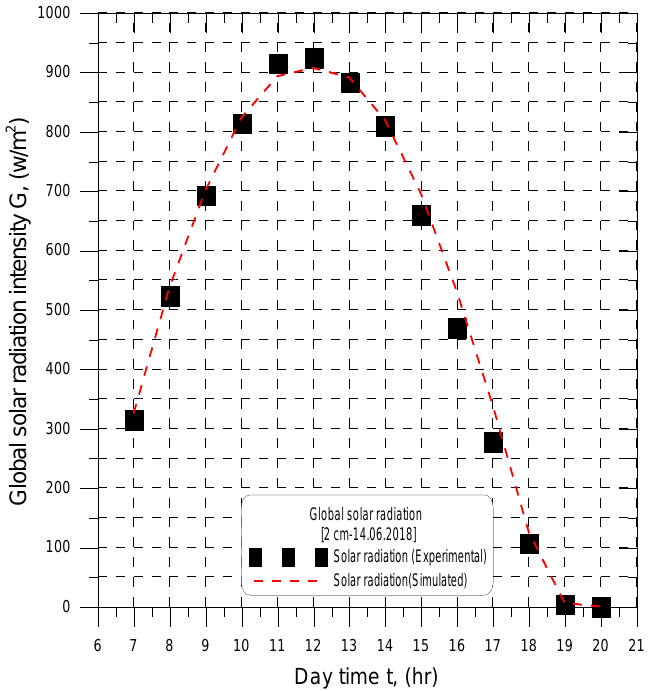
Figure 7. Hourly variation of simulated and experimental solar radiation intensity on 14 June.